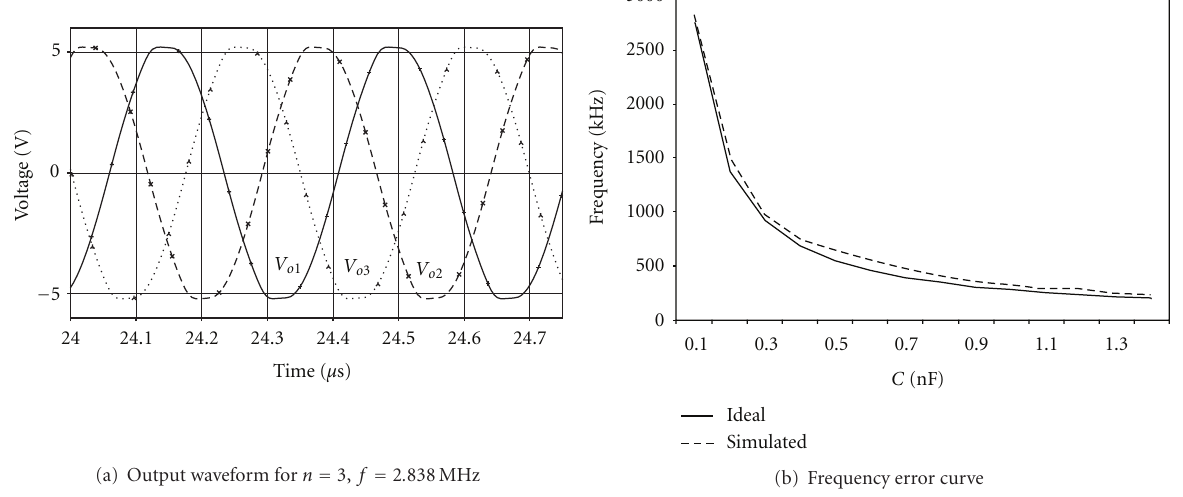
Figure 7: Simulation result for circuit